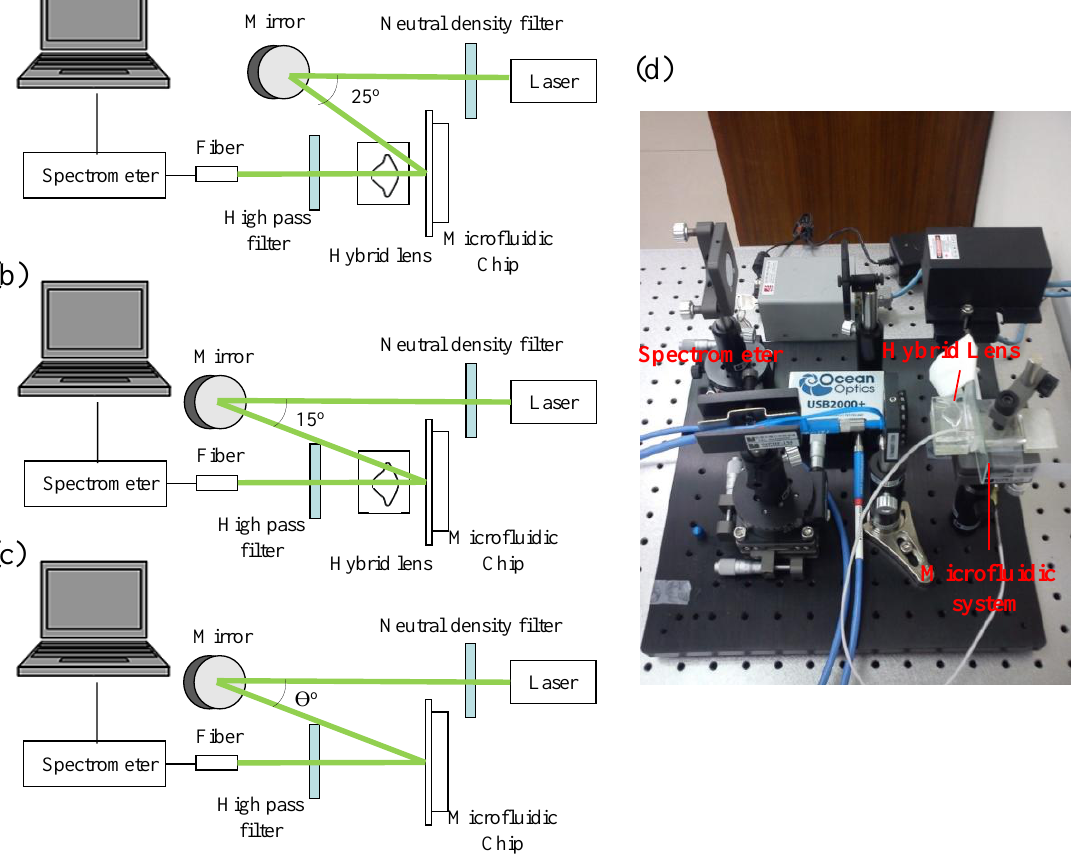
Figure 4. Optical setups of ( a ) measurement using fluorescence collecting lens; ( b ) measurement using hybrid lens; and ( c ) measurement without lens, θ is 15° or 25°, depending on experiments; ( d ) Photography of the optical experiment setup in ( b